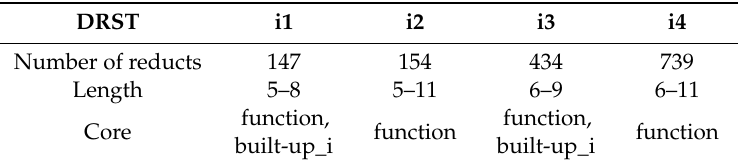
Table 3. Number, size, and cores of reducts designated by the DRST method for the selection of buildings. DRST i1 i2 Number of reducts function, function, function Core built-up_i built-up_i